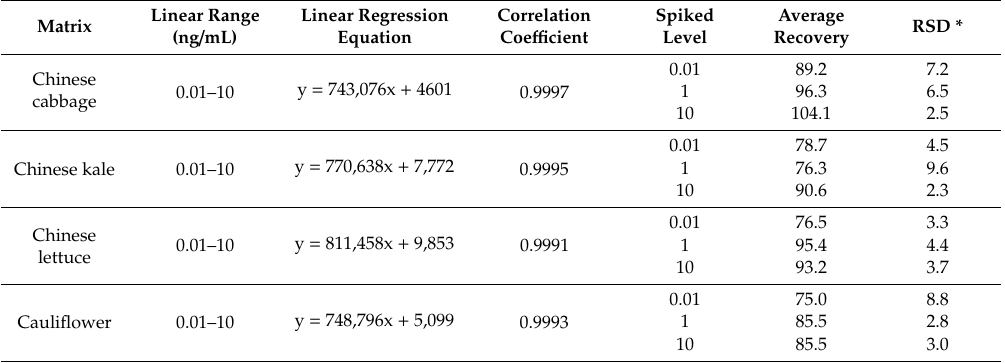
Table 4. Linear range, linear equation, correlation coe ffi cient, recovery, and relative standard deviation (RSD) of